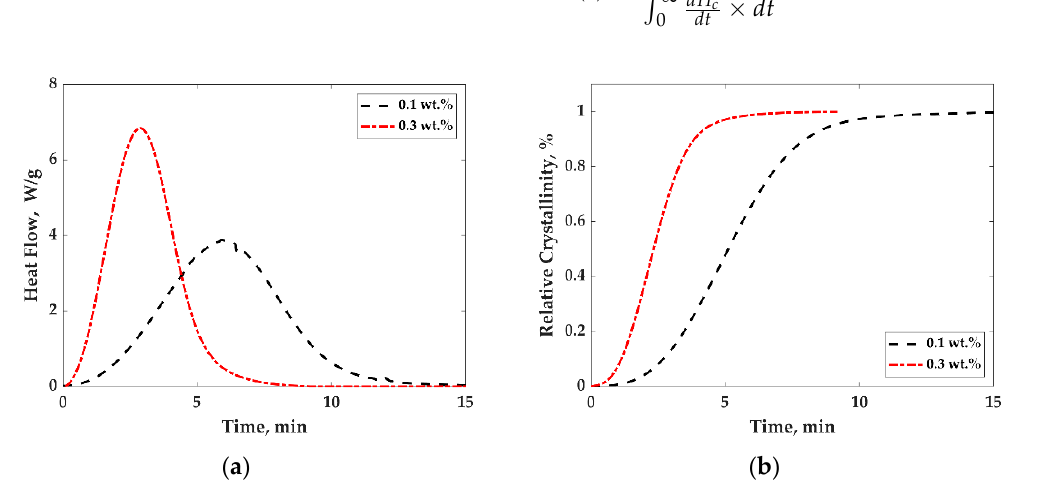
Figure 9. ( a ) Heat flow as a function of time for PP/MWCNTs composites with different MWCNTs wt.% at 135 °C; ( b ) relative crystallinity of PP/MWCNTs composites with different MWCNTs wt.% at 135 °C.